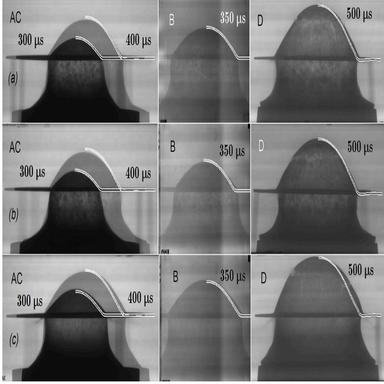
Experimental flash X-ray results and comparison with the calculations (shown as half plate white contours) for the calcite sands: as-received, ρ0 = 1.33 g/ cm3 (a), pre-compacted, ρ0 = 1.45 g/cm3 (b) and moisturised, ρ0 = 1.21 g/cm3 (c) loaded by the configuration V charge.